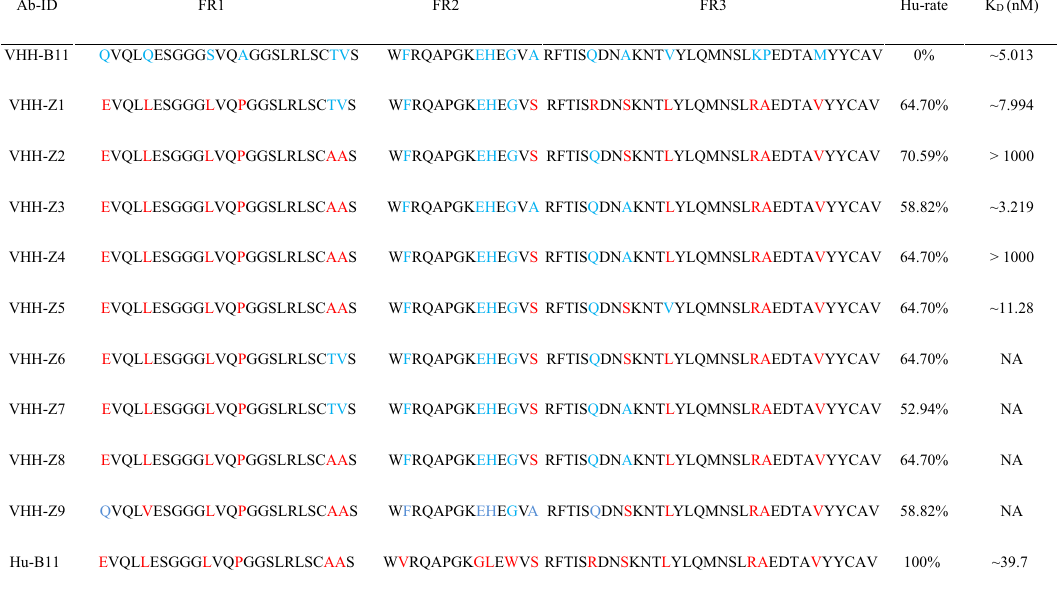
Table 2. VHH-B11 Ab and its humanized mutants. Ab ID is the name of VHH-B11 and each mutant. VHH- B11 is the wild type. The blue letters represent the locations of 17 “hotspot” humanization amino acids. Z1–Z9 are nine VHH-B11 humanized mutants, and each mutates at several of the hotspots. The mutated amino acids are labeled in red. Hu-B11 is a highly humanized mutant that mutates at all 17 hotspots. FR1-3 represents the three frameworks of VHH-B11. Hu-rate is short for the relative humanized rate (%). In this study, 17 amino acid mutations indicate 100% humanization rate. The Hu-rate is equal to the number of mutated amino acids divided by 17. K D (M) is the affinity between VHH-B11 mutant and hPCSK9 and is measured by the SPR technology at 25 ℃ . “NA” represents not